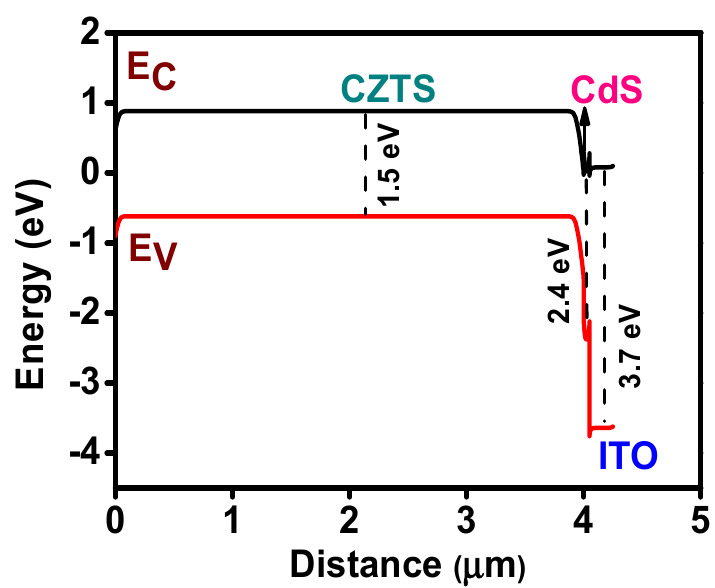
Figure 7. Schematic Energy band diagram for CZTS/CdS/ITO.